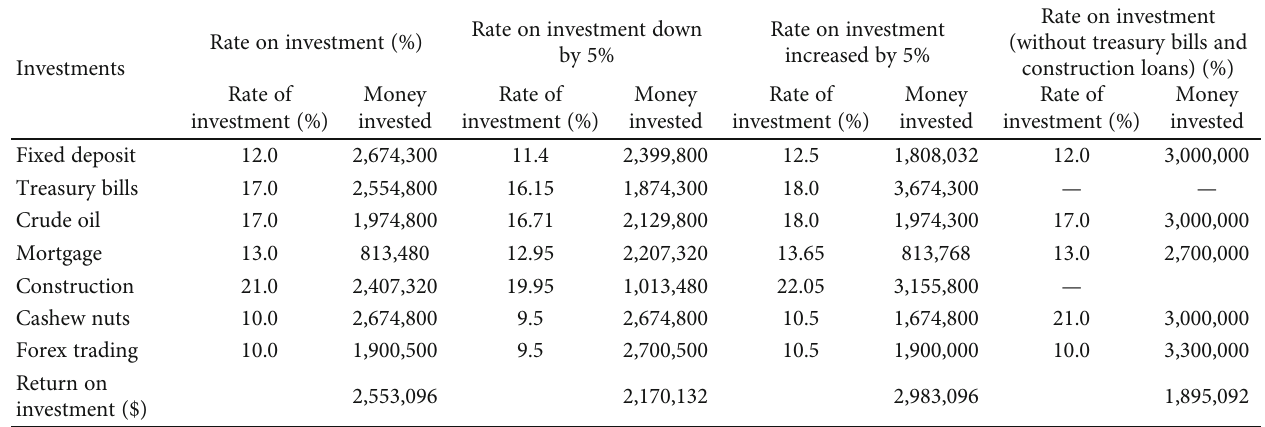
Table 5: The result and summary of the